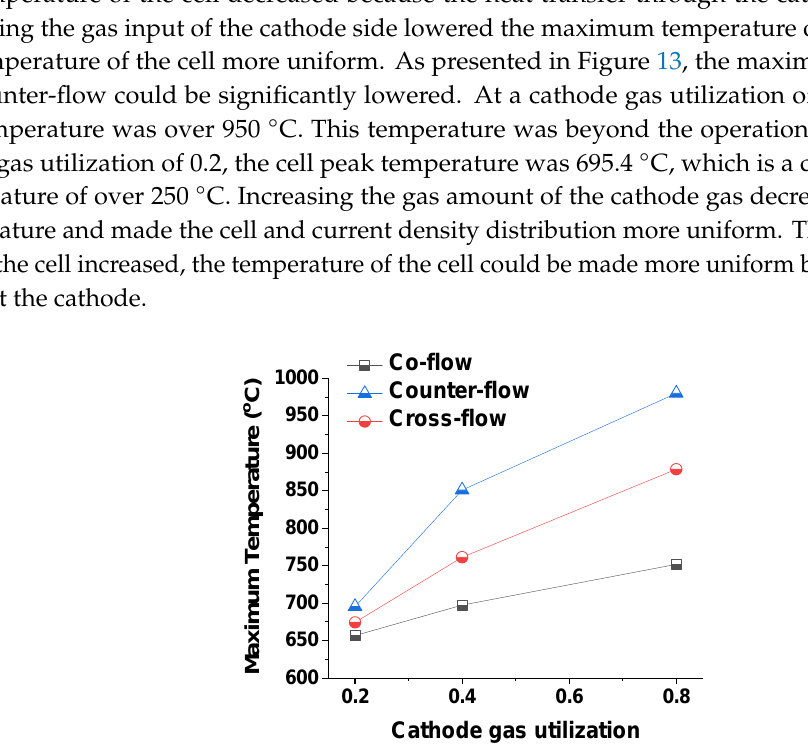
Figure 13. Maximum cell temperatures relative to the cathode gas utilization for each flow type.